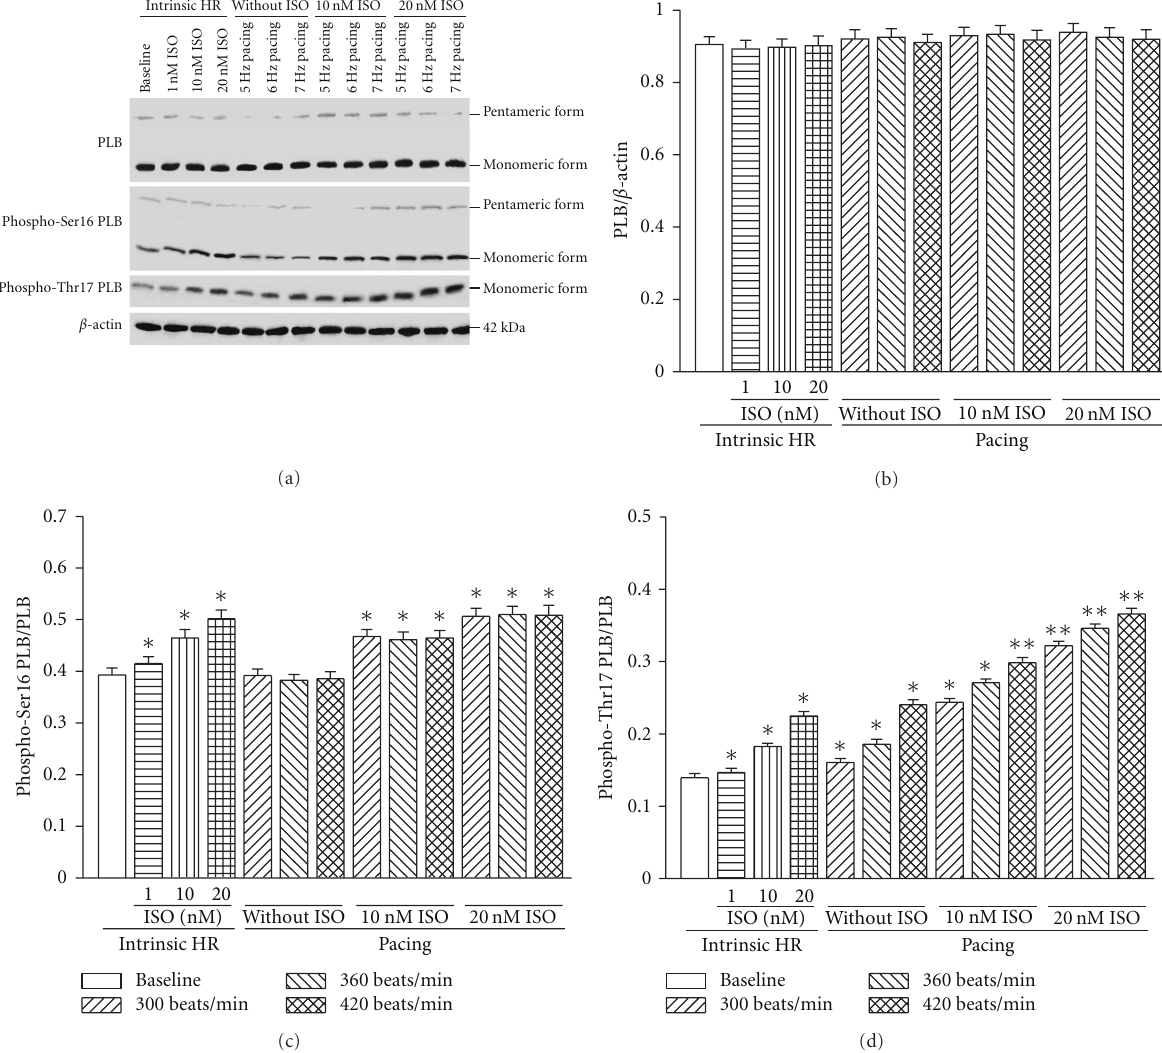
Figure 7: Expression of PLB, phosphorylated PLB at Ser16 (phospho Ser16-PLB) and at Thr17 (phospho Thr17-PLB) in the myocardium after the pacing and ISO treatment. (a) The representative Western blots of PLB, phosphorylated PLB at Ser16 and Thr17. (b) Expression of total PLB measured by pentametric plus monomeric forms. (c) Expression of phospho Ser16-PLB. (d), expression of phospho Thr17-PLB. Data are mean ± SEM, n = 6 hearts in each group. ∗ P < 0 . 05 or ∗∗ P < 0 . 01 versus